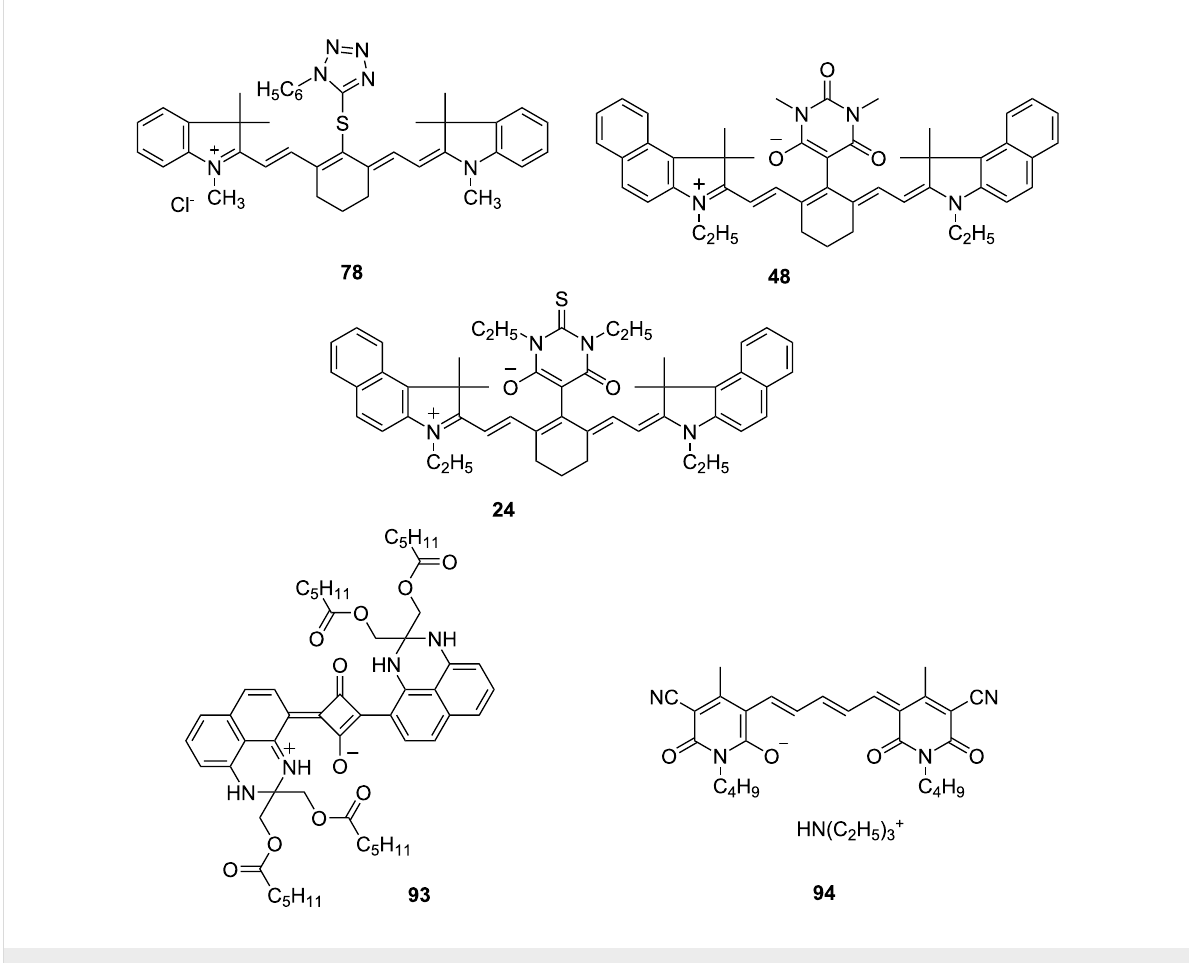
Scheme 10: The structure of Sens used in photo-ATRP.